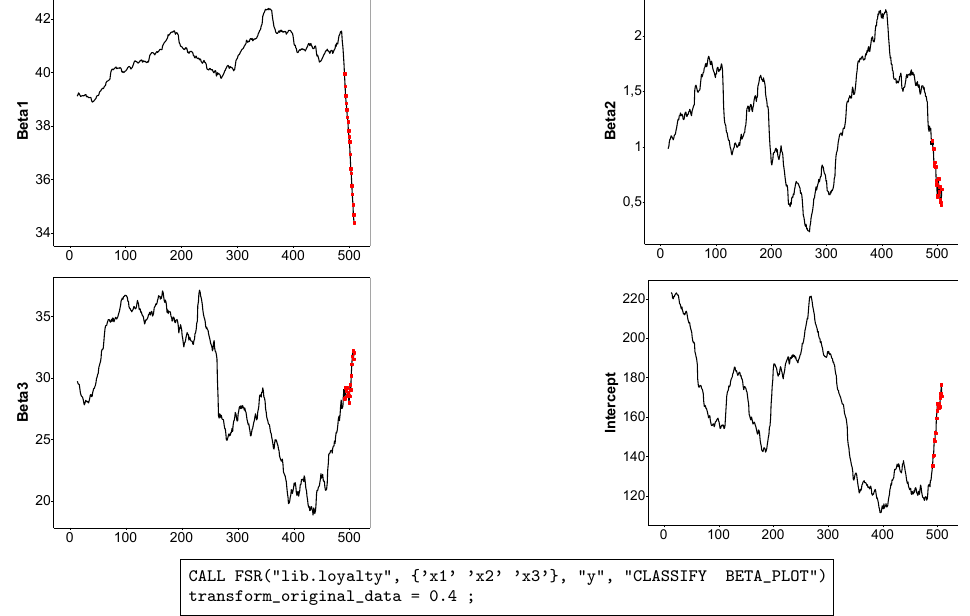
Figure 5. Loyalty card data: monitoring of the estimated beta coefficients on transformed data when λ = 0.4, with the part of the trajectory corresponding to the 18 detected outliers highlighted in red (in the online .pdf version). The box under the figure contains the SAS code used to generate the plots.